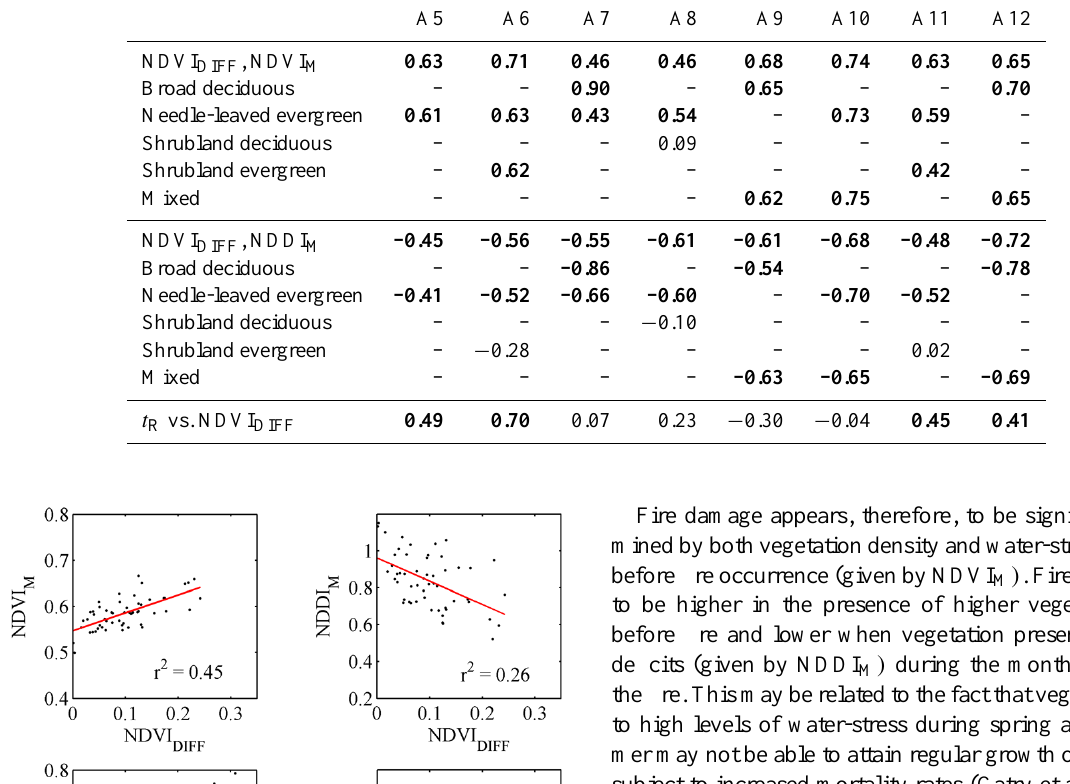
Table 3. Correlation coefficients between NDVI DIFF , t R and NDVI M , NDDI M . Bold numbers correspond to statistically significant values at 5% level.